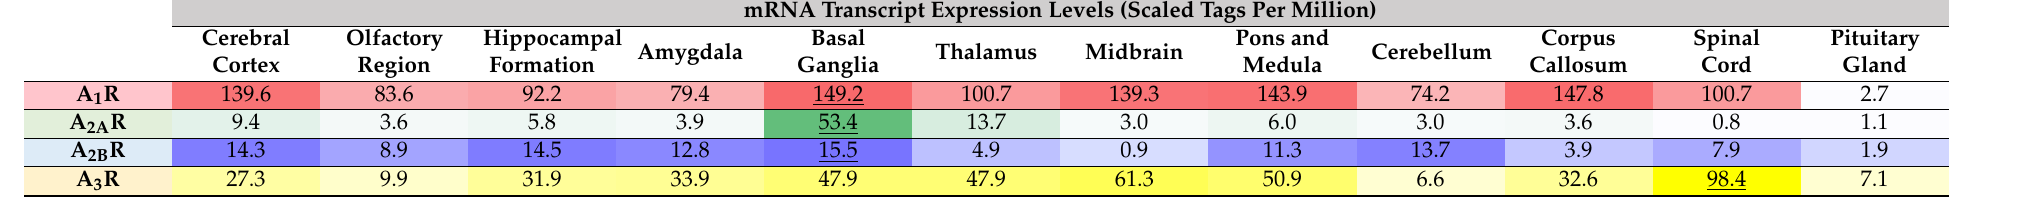
Table 1. Comparative expression of mRNA transcripts of adenosine receptor in different regions of human